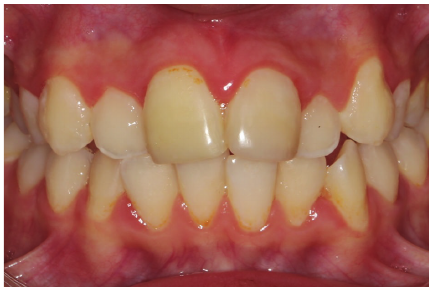
Figure 9: Frontal view, 12 months after trauma.